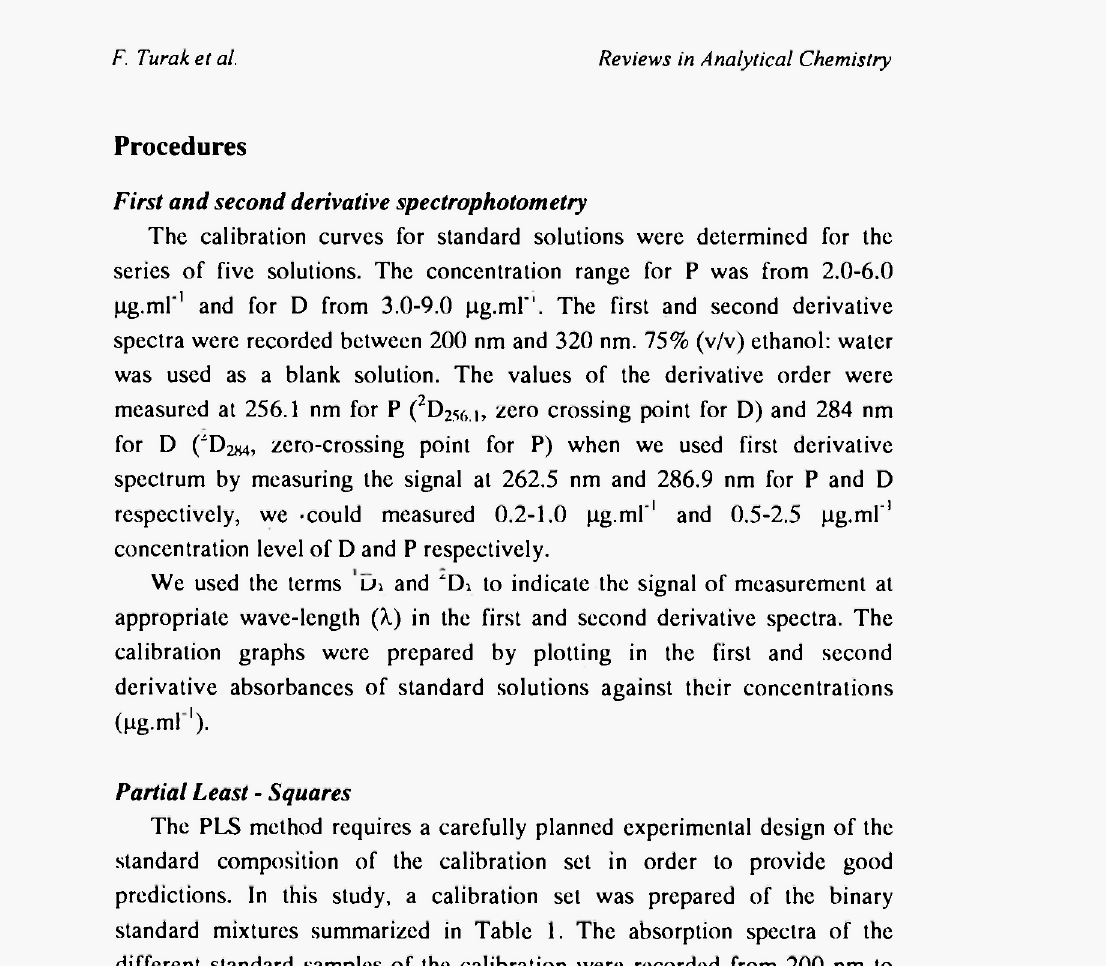
Set of calibration sample mixtures of Dazomet and